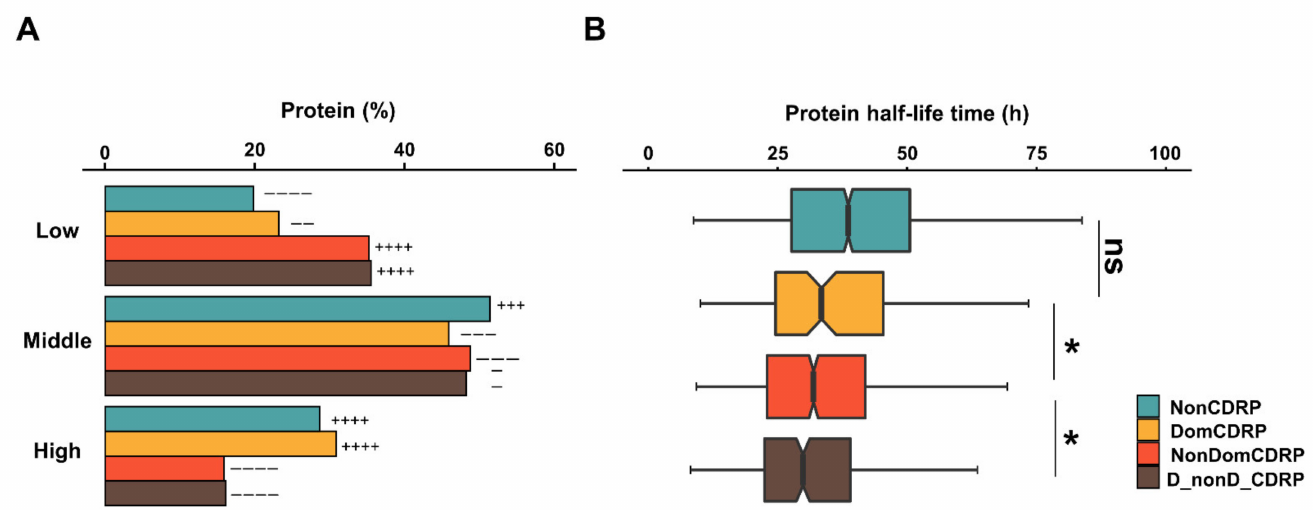
Figure 5. The abundance ( A ) and the half-life time ( B ) of four types of proteins. Proteins were classified into three groups (low, middle, and high, see Figure S3 for detailed information). ( A ) Histograms show the percentages of the three groups of proteins in each of the four types. Fisher’s exact test was used to calculate the over- or under-representation strength. − − represents q ≤ 0.05, +++/ − − − represents q ≤ 1 × 10 − 10 ; ++++/ − − − − represents q ≤ 1 × 10 –50 . ( B ) Box plots show the half-life time values of the four types of proteins. The values of the upper and lower quartiles are indicated as upper and lower edges of the box, and the median values are indicated as bars in the box. The differences are measured by Wilcoxon rank sum test and p -values were adjusted by step-down Bonferroni; *, q <